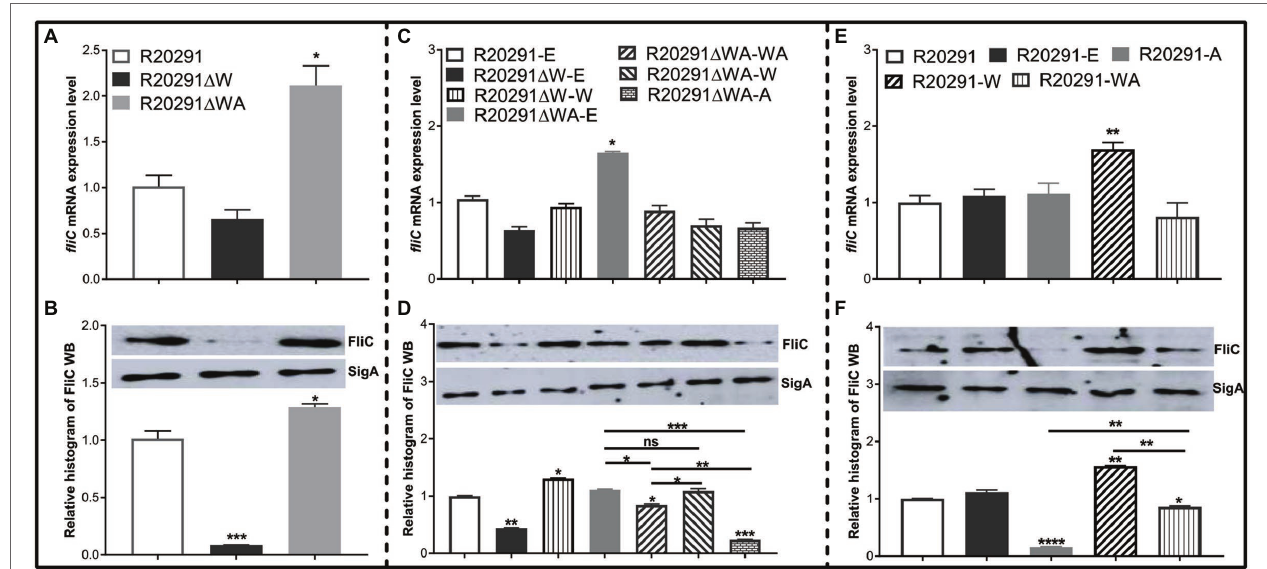
FIGURE 4 | fliC expression analysis. (A,C,E) Analysis of fliC expression on transcription level. (B,D,F) Analysis of fliC expression on translation level by Western blot. SigA protein was used as a loading control. Experiments were independently repeated thrice. Bars stand for mean ± SEM (* p < 0.05, ** p < 0.01, *** p < 0.001, and **** p < 0.0001). One-way ANOVA with post hoc Tukey test was used for statistical significance. **** upon the column directly means the significant difference of experimental strain compared to R20291 or